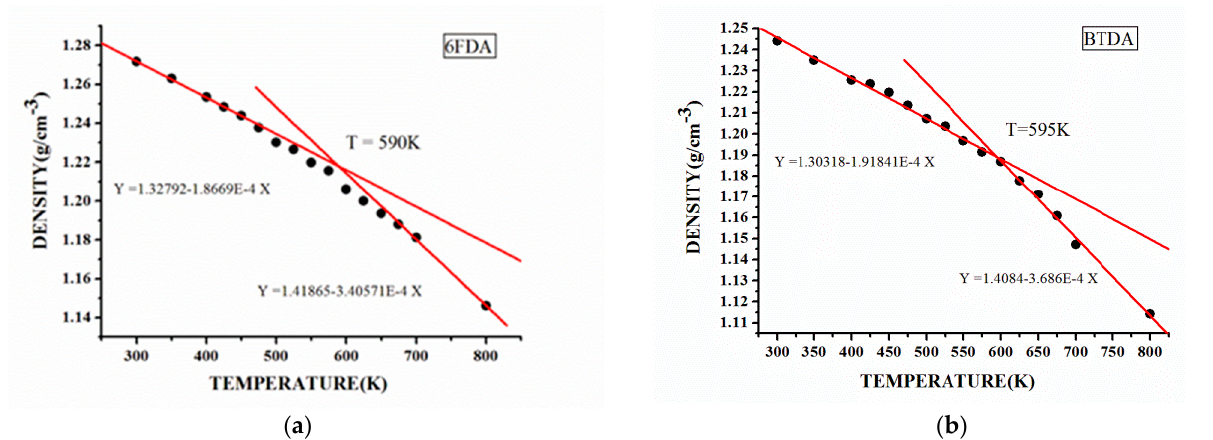
Figure 5. The linear fitting results of density variation with temperature of each simulated